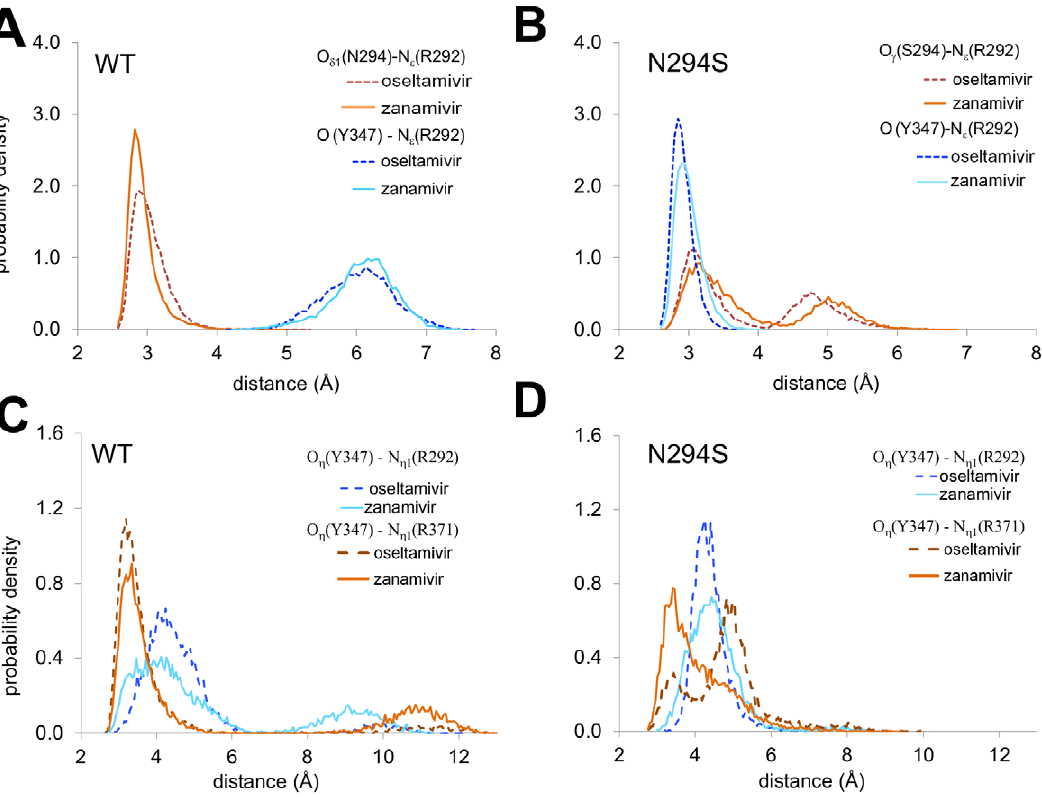
Figure 5. Comparison of WT and N294S mutant dynamics. ( A ) Distance distributions between the R292 N e atom and N294 O d 1 and Y347 carbonyl O atoms computed from SRSM/HREX simulations of the WT enzyme in complex with oseltamivir and zanamivir. ( B ) Distance distributions between the N e atom of R292 and S294 O c and Y347 carbonyl O atoms computed from simulations of the complexes of the N294S mutant with the two drugs. ( C ) Distributions of distances between the Y347 O g atom and N g 1 atoms from R292 and R371 computed from SRSM simulations of the WT enzyme in complexes with the two drugs and ( D ) for the complexes of the N294S mutant with oseltamivir and zanamivir.